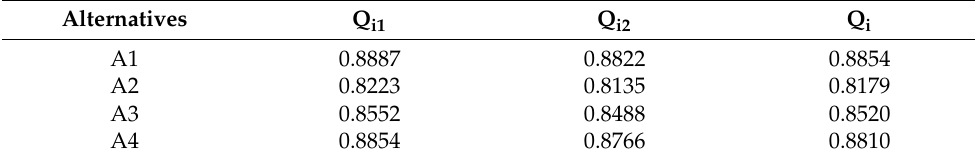
Table 8. Rank results of four potential renewable energy resource.